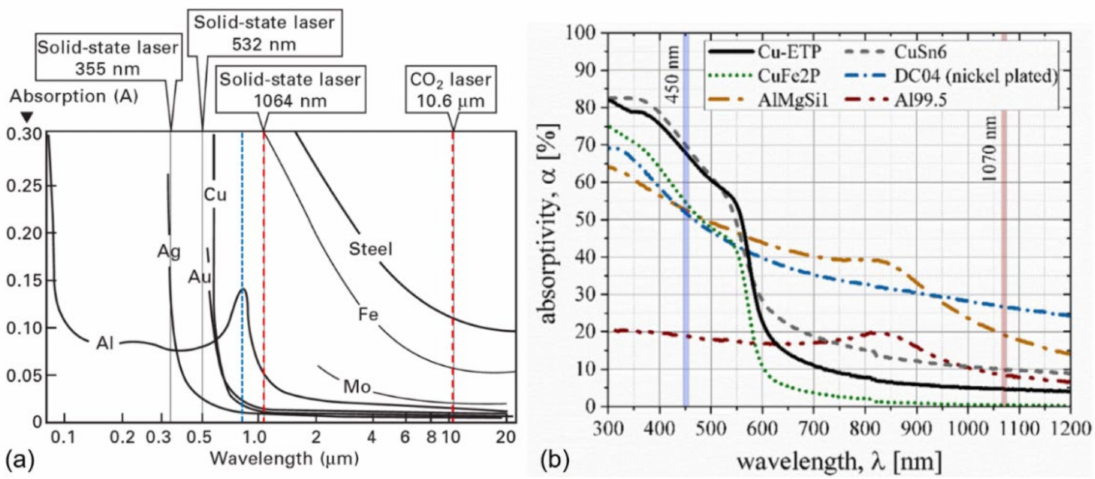
Figure 6. Absorption of laser beam by different metals depending on laser wavelength in ( a ) wide spectrum [61] and in ( b ) short-wavelength spectrum